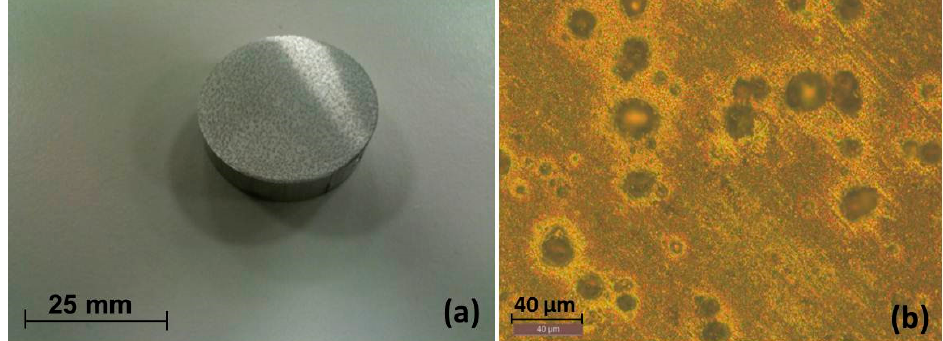
Figure 15. Optical images of aluminum surface after 10 days of immersion in 3.5% NaCl solution at ( a ) low magnification, ( b ) enlarged magnification.